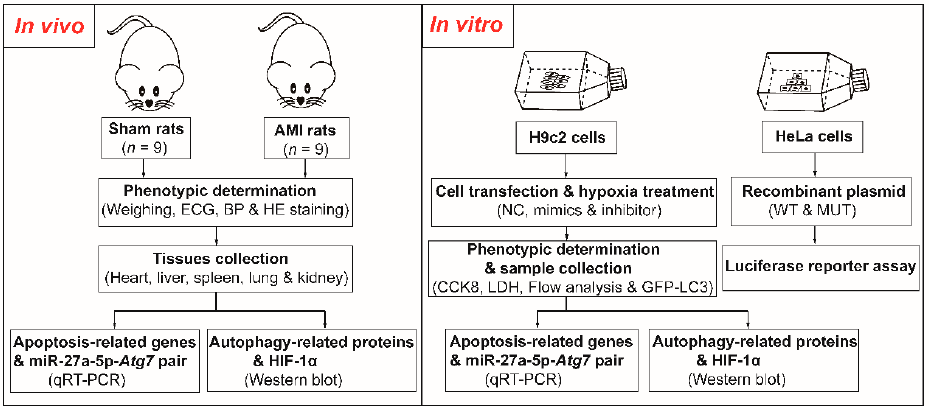
Figure 1. The flow chart of this study. ECG, electrocardiogram; BP, blood pressure; HE staining, hematoxylin & eosin staining; qRT-PCR, quantitative reverse-transcription polymerase chain reaction NC, negative control; CCK8, cell counting kit-8; LDH, lactate dehydrogenase; WT / MUT, wild-type / mutant.